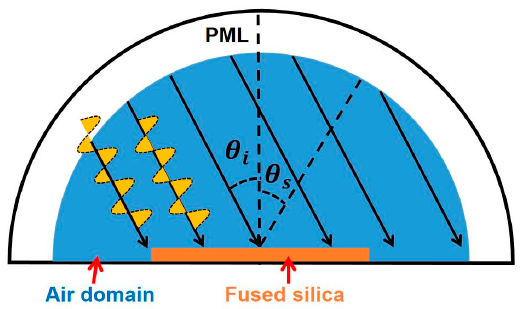
Figure 5. Schematic diagram of the surface sca tt ering simulation model.